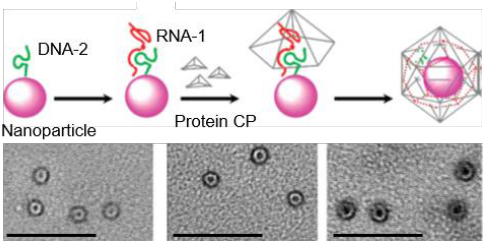
Figure 5. RCNMV VLPs templated by NPs. ( Top panel ): schematic representation of the templated assembly of RCNMV on NPs. ( Bottom panel ): TEM images of RCNMV VLPs containing magnetic CoFe 2 O 4 NPs of different sizes. Scale bar: 200 nm. Reprinted with permission from [71]. Copyright (2007) American Chemical Society.